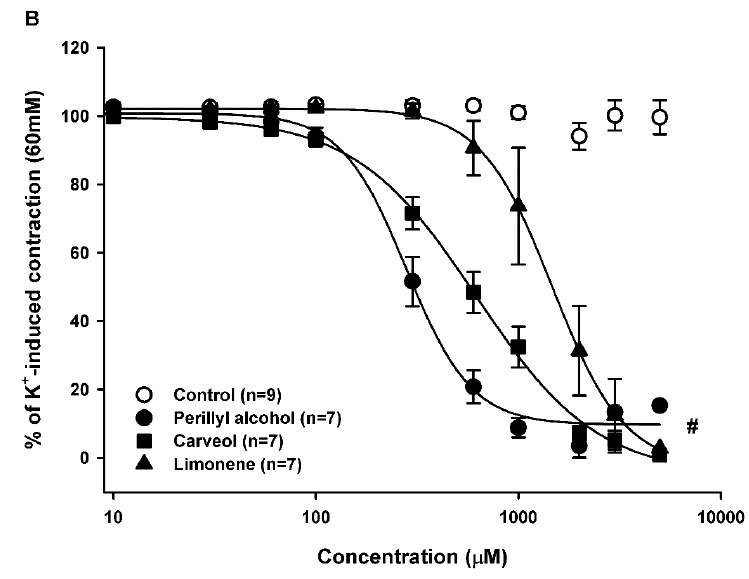
Figure 3. Relaxant effect of limonene, carveol, and perillyl alcohol on electromechanical coupling. Sustained contractions induced by K + (60 mM) in endothelium-intact ( A ) and endothelium-denuded ( B ) rat aortic rings. Results are shown as means ± SEM. # indicates statistical difference of limonene, carveol, and perillyl alcohol compared to the control ( p < 0.05, two-way ANOVA and Holm-Sidak test). Each control consisted of the same concentration of vehicle as in the experimental case, but without the experimental substance. Table 1. EC 50 values summarizing the relaxant effects of perillyl alcohol, carveol, and limonene on rat aortic rings. Values are expressed as means ±